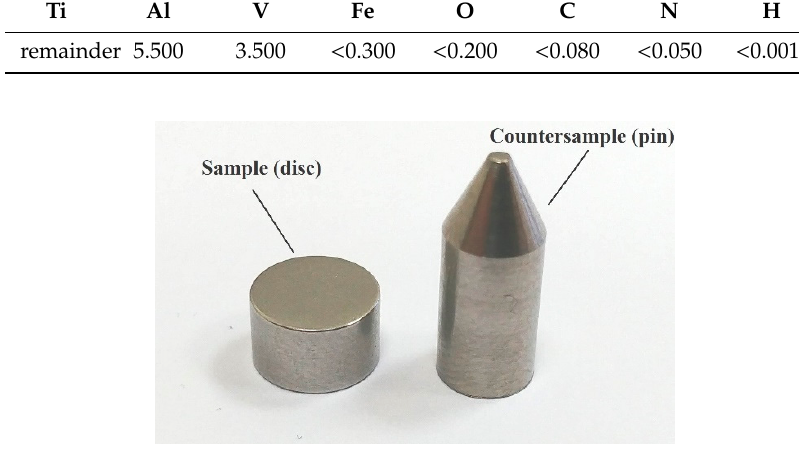
Figure 1. Image of the samples’ geometry.